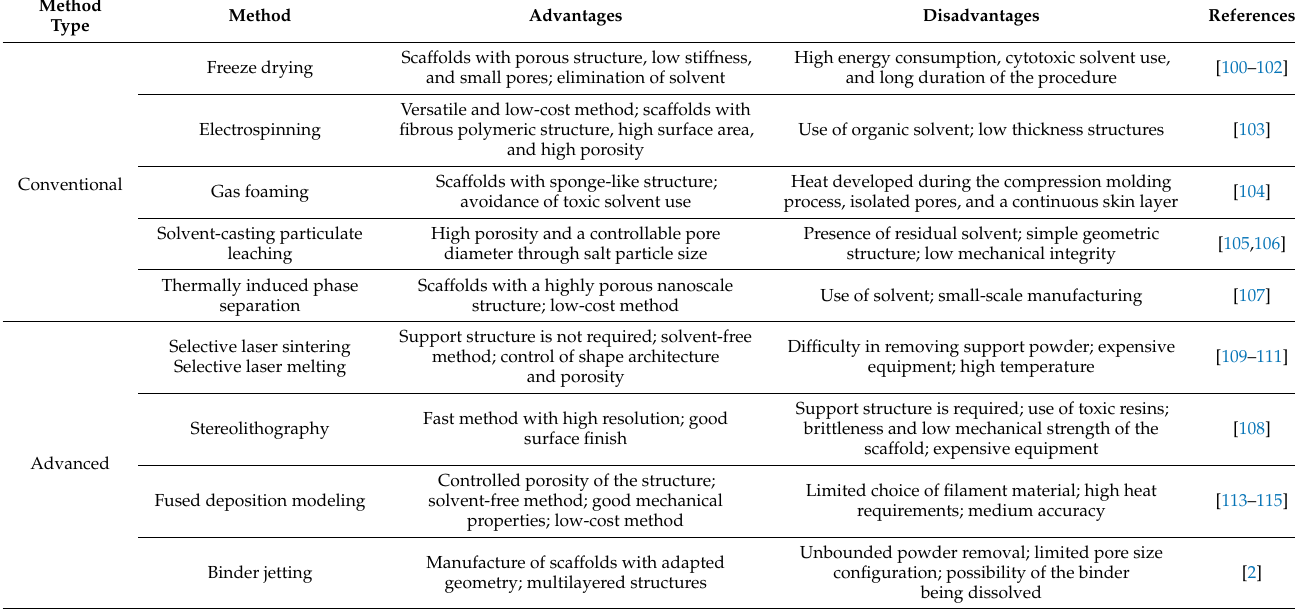
Table 2. Main polymeric scaffold manufacturing